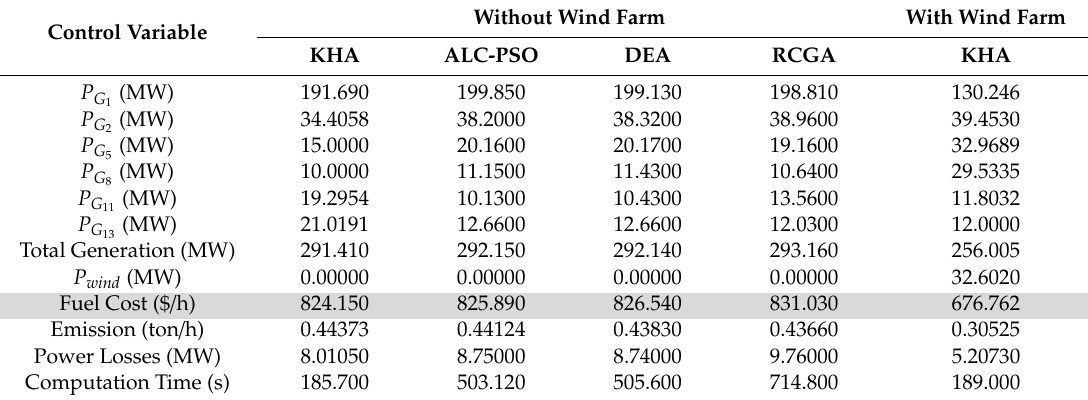
Table 4. Results for fuel cost minimization considering the valve-point e ff ect for the Test System 1. Control